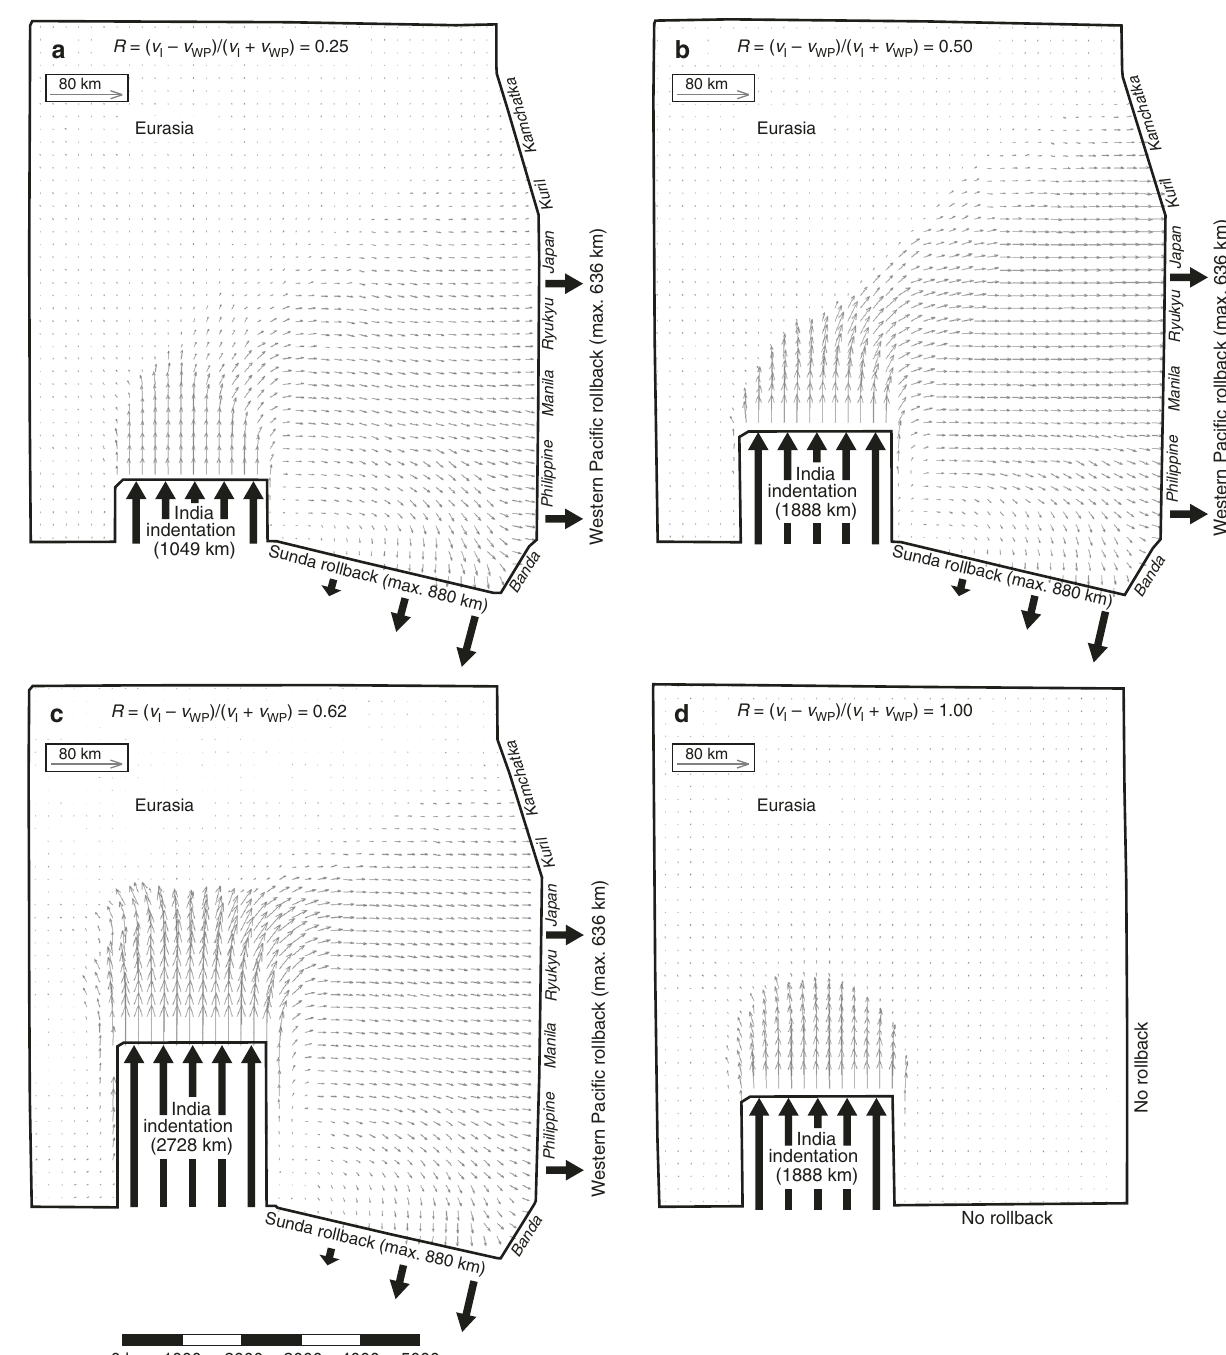
Fig. 5 Top views of four experiments simulating Asian deformation with different velocity ratios ( R ) showing the horizontal in fi nitesimal displacement fi eld. The results are shown for the end of each experimental run. a Experiment I MIN -R with R = 0.25 (minimum indentation). b Experiment I INT -R with R = 0.50 (intermediate indentation). c Experiment I MAX -R with R = 0.62 (maximum indentation). d Experiment I INT -NR with R = 1.00 (intermediate indentation and no rollback). The in fi nitesimal displacement fi eld is determined for the last 40 min (~0.866 Myr) of the experiment. Note that the displacement fi elds in a –